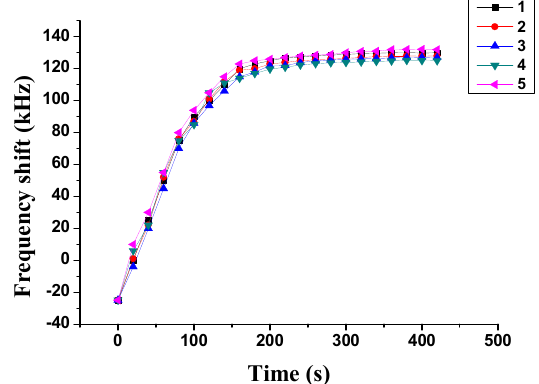
Figure 9. Repeatability of the Love wave humidity sensor at 60 %RH.